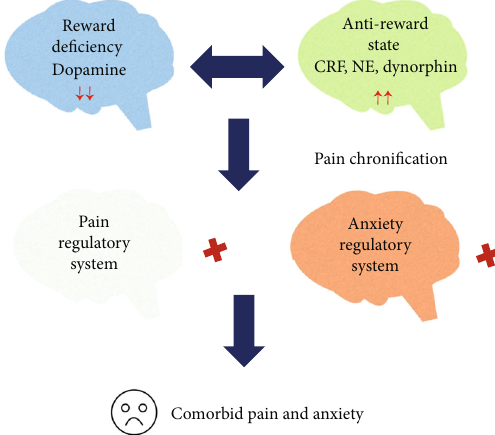
Figure 1: Possible explanation of the comorbidity of chronic pain and anxiety. Persistent pain inhibits the brain ’ s reward and motivational (NAc) — and diminishes the motivational/incentive salience of natural reinforcers (reward de fi ciency). In response to this state, the antireward system center — the lateral habenular (LHb) — is overexcited, releasing stress-related chemicals — including corticotropin-releasing factor (CRF), norepinephrine (NE), and dynorphin — leading to excessive dopaminergic tra ffi cking (reduced dopamine receptors, diminished dopamine synthesis, and increased dopamine transporters) that results in the dysfunction of the pain and anxiety regulatory system (pain chroni fi cation). The pain and anxiety syndromes in chronic pain patients are thus the result of the dysfunction of the regulatory